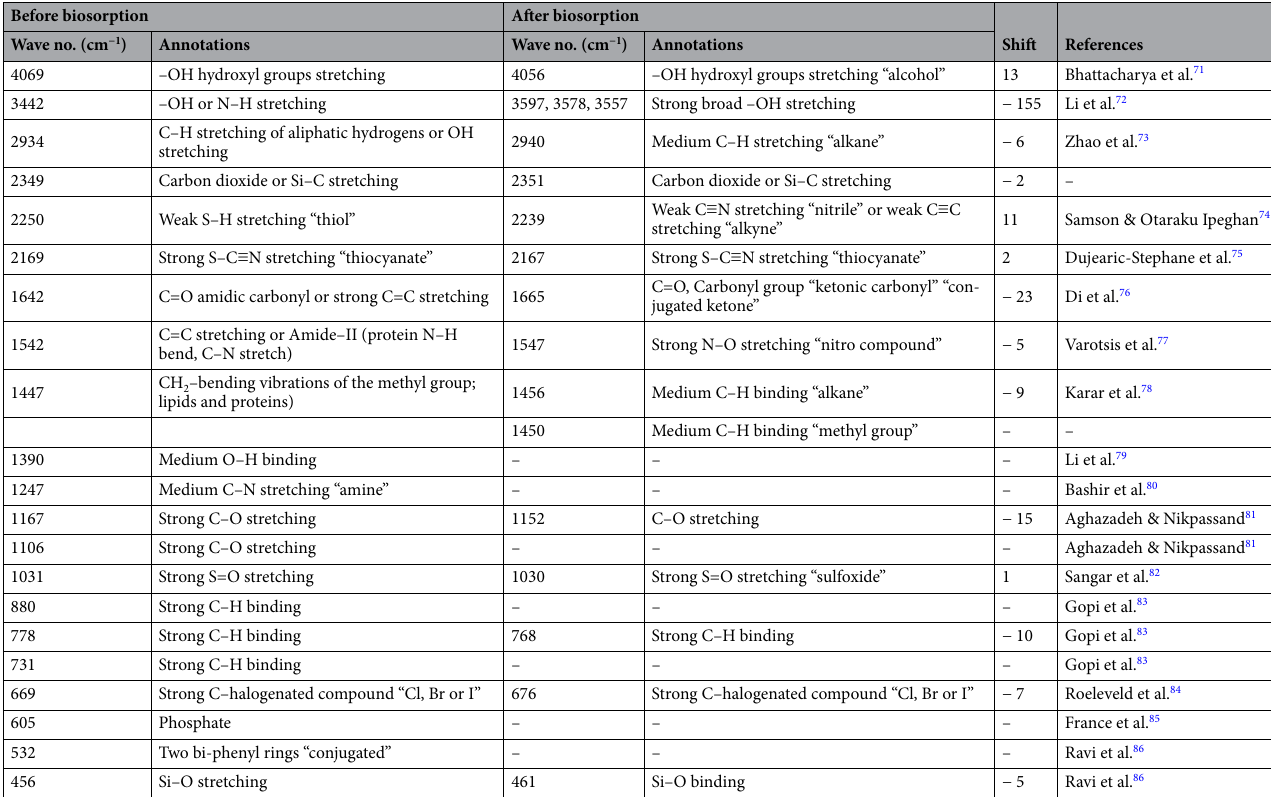
Table 6. FTIR spectral analysis of Gelidium corneum biomass before and after biosorption of Hg 2+ and Remazol brilliant blue